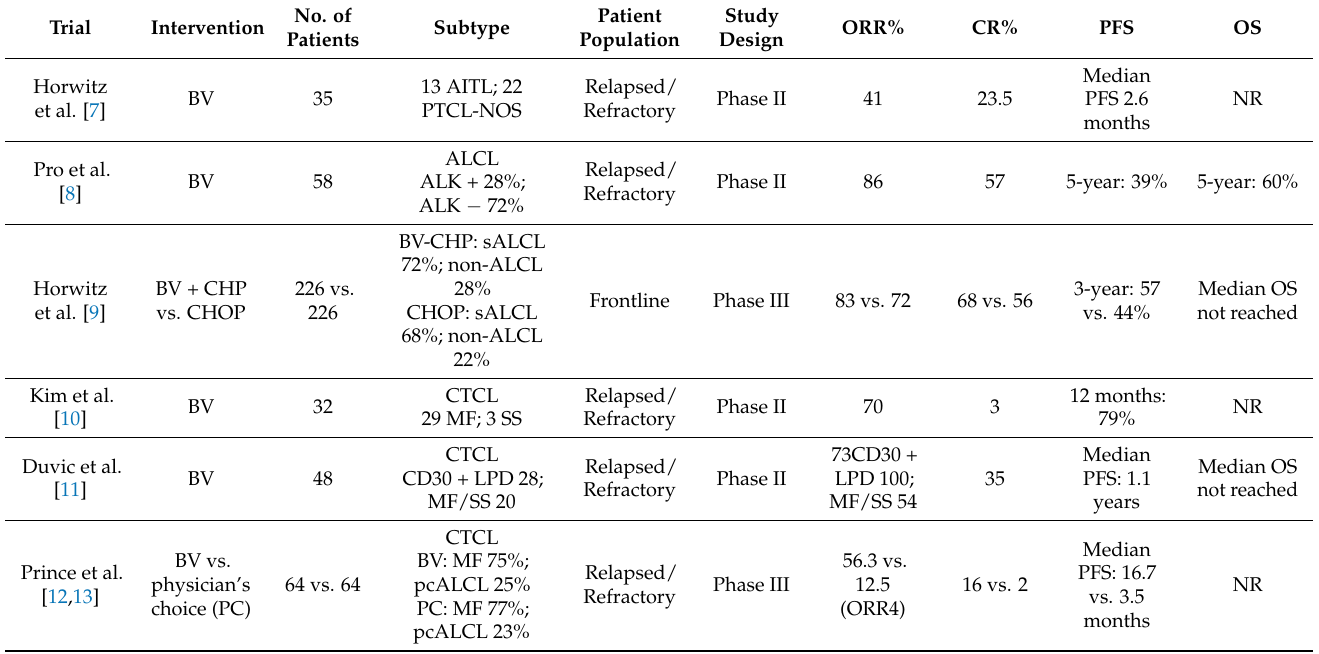
Table 1. Prospective trials of CD30 antibody–drug conjugate Brentuximab Vedotin in T-cell lymphoma. Trial